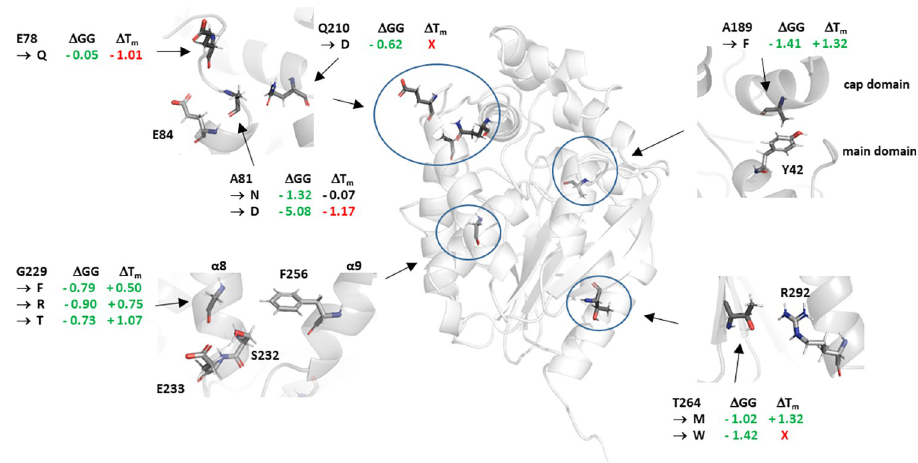
Fig 2. A comparison between experimentally-determined melting temperature of LinB mutants ( Δ T m ) and the predicted changes in the Gibbs free energy ( Δ GG). Green colour indicates increase in stability, and red colour indicates decrease. Red X indicates failure during mutant production. The positions of the zoomed-in regions were rotated to facilitate analysis of crucial